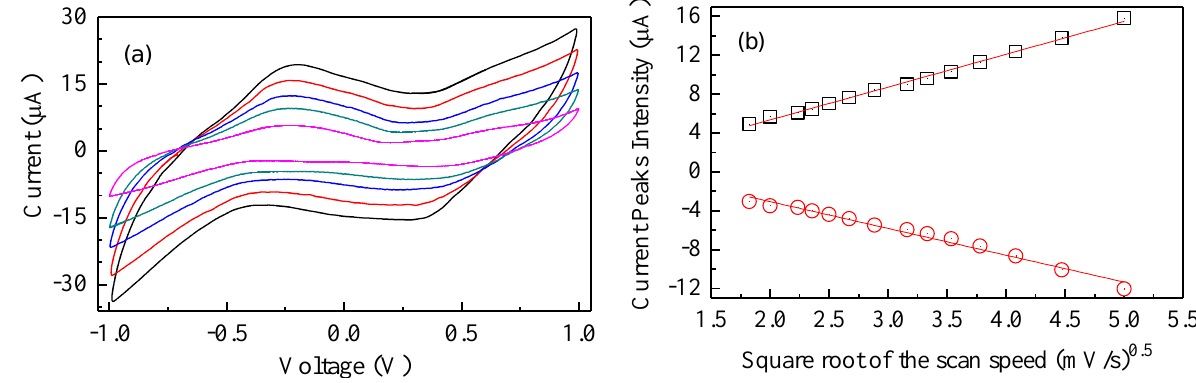
Figure 6. ( a ) Steady state current-voltage cycles of a typical Au/Nafion/ MWNTs-Nafion:Cu/Au cell, measured over the same voltage range in pure deionized water, at different scan rates. ( b ) Forward (squares) and reverse current peaks intensity (circles), plotted as a function of the square root of the scan rate. The solid lines represent the results of linear fitting analysis.